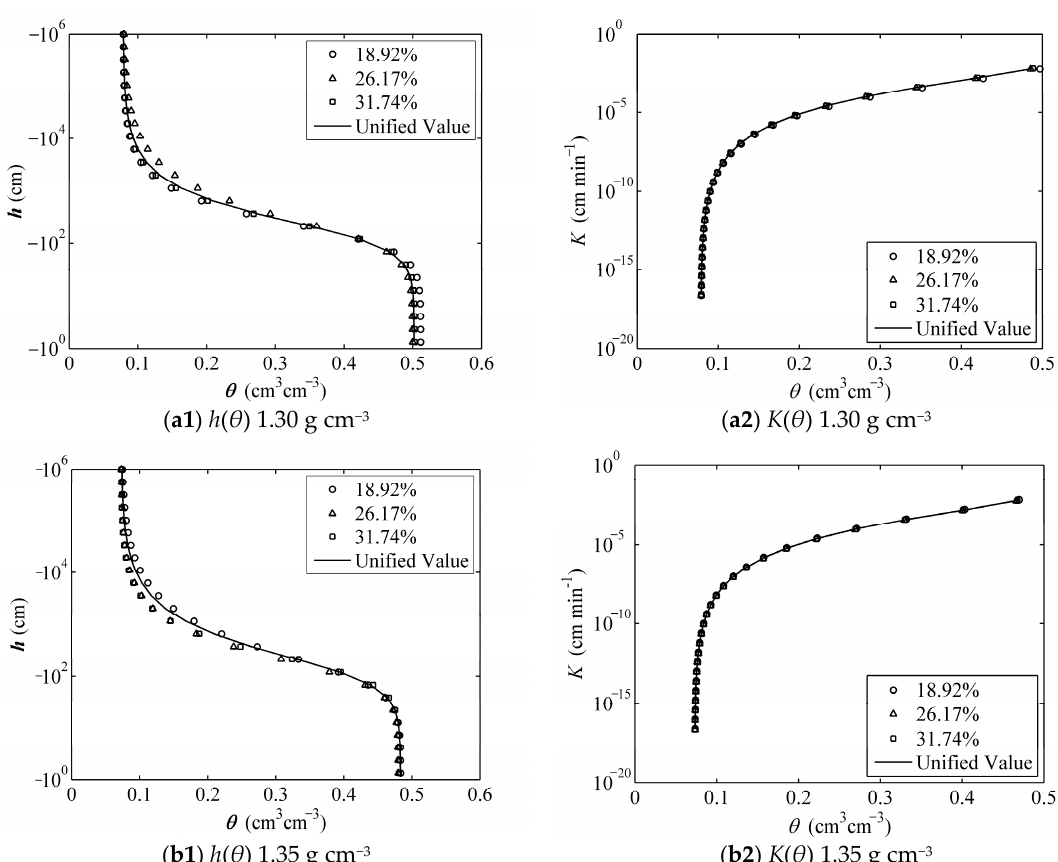
Figure 11. Comparison of soil water conductivity curves and SWRCs of the three experimental solutions.